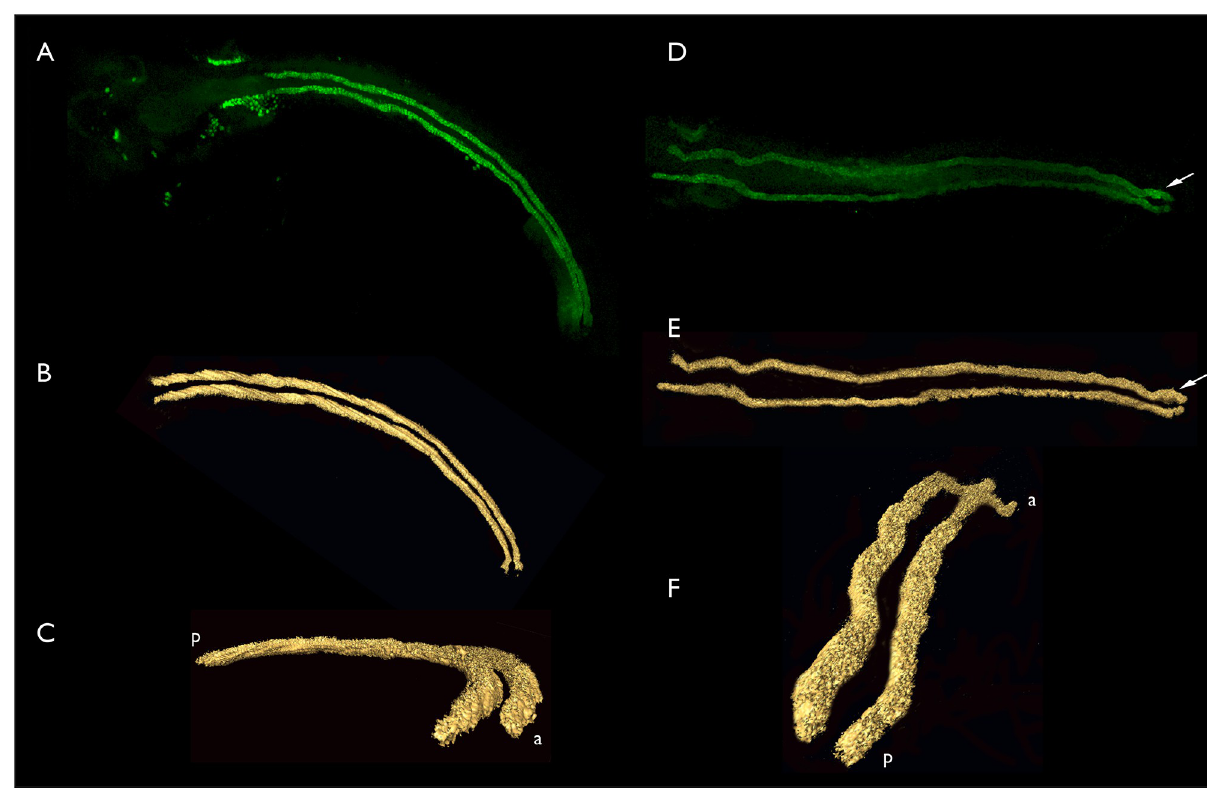
Fig 6. Confocal image stacks and computer generated renderings of aglomerular kidney structure in bay pipefish late pharyngula embryos. A-C, three views of a single set of aglomerular tubules. A. Dorsal view, anterior left, confocal stack. B. AMIRA generated surface model of the data illustrated in panel A. C. The same model as illustrated in panel B rotated so that the anterior portion of the kidney is on the lower right, closest to the viewer. a, anterior; p, posterior. D-F, three views of a single set of aglmoerular tubules. D. Confocal stack. E. AMIRA surface model of the same set of tubules as illustrated in D. F. The model illustrated in E rotated with the posterior end now closest to the viewer. a, anterior; p, posterior. 3D rotations of these models can be viewed in S1–S4 Videos.